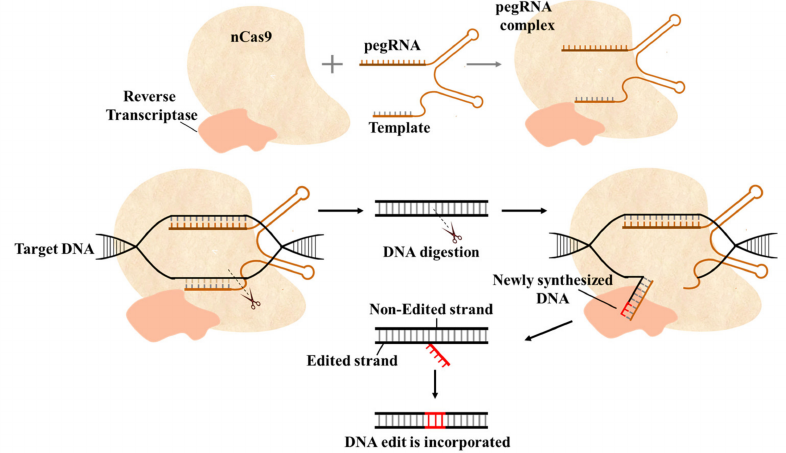
Figure 7. Schematic diagram of prime editing, which involves fusing nCas9 with reverse transcriptase and a prime editing guide RNA (pegRNA). Prime editing systems edit DNA without causing DSBs, and the reverse transcriptase can accomplish various transitions, insertions, and